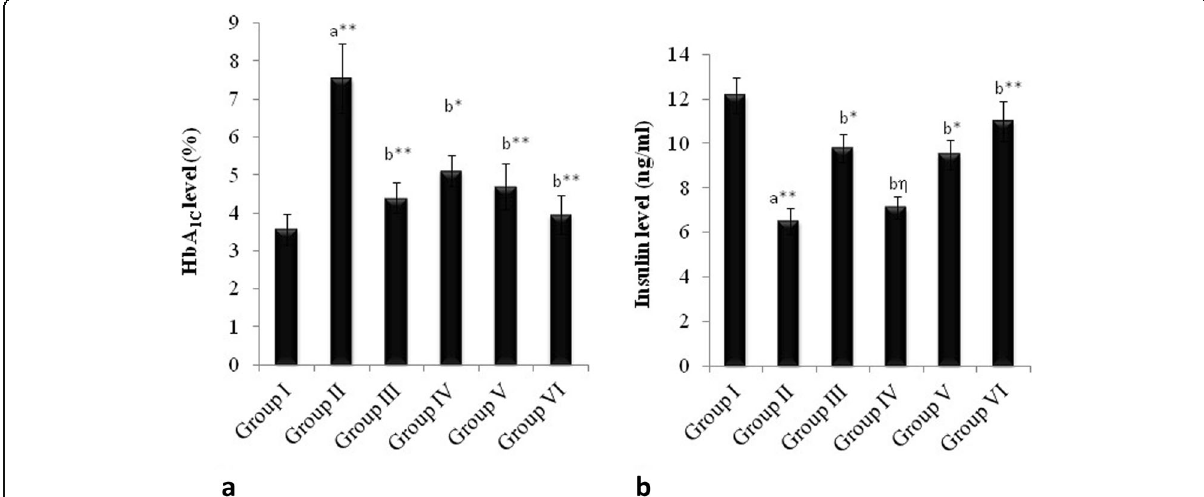
Fig. 1 Effect of C. reflexa methanol extract (CRME) on HbA 1C ( a ) and insulin level ( b ). All values were expressed as mean ± S.E.M ( n = 3). (*) designates statistically significant difference from the respective group (** p < 0.01) whereas ( η ) indicates statistically no significant difference from the relevant group ( p > 0.05) using ANOVA, followed by Dunnett ’ s multiple comparison test. a = while compared with healthy control, b = while compared with diabetic control. Group I = Healthy control, Group II = Diabetic control, Group III = Diabetic control + 10 mg/kg of gliclazide, Group